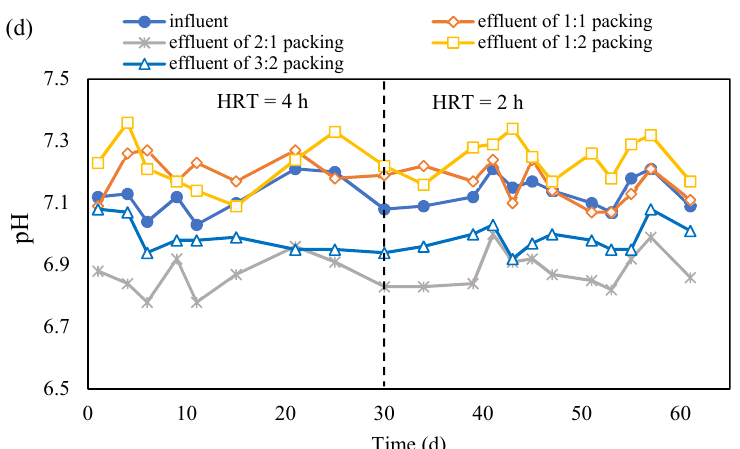
Figure 3. The variation in NO 3− -N ( a ), NO 2− -N ( b ) and SO 42− ( c ) concentration and pH ( d ) in the effluent of S 0 and corncob mixing system (S 0 presents the element sulfur; NO 3− -N presents the nitrate nitrogen; NO 2− -N presents the nitrite nitrogen; HRT presents the hydraulic retention time; ‘effluent of 1:1 packing’, ‘effluent of 2:1 packing’, ‘effluent of 1:2 packing’ and ‘effluent of 3:2 packing’ present the effluent collected from the reactor packed with corncob and S 0 with a ratio of 1:1, 2:1, 1:2 and 3:2, respectively).